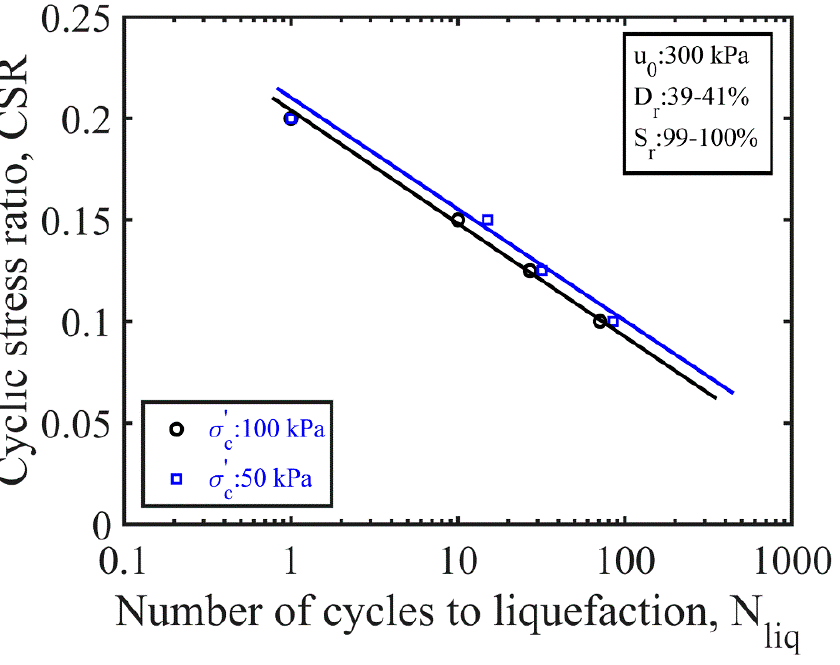
Figure 7. Effect of confining stress on liquefaction resistance of nearly/fully saturated sand speci- mens.